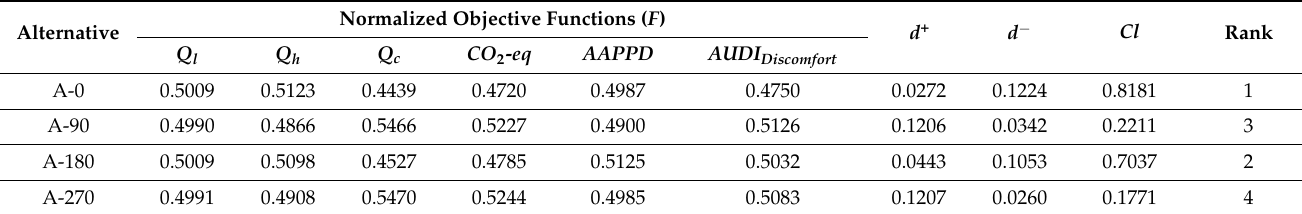
Table 4. The TOPSIS results for different orientations of the building type A.